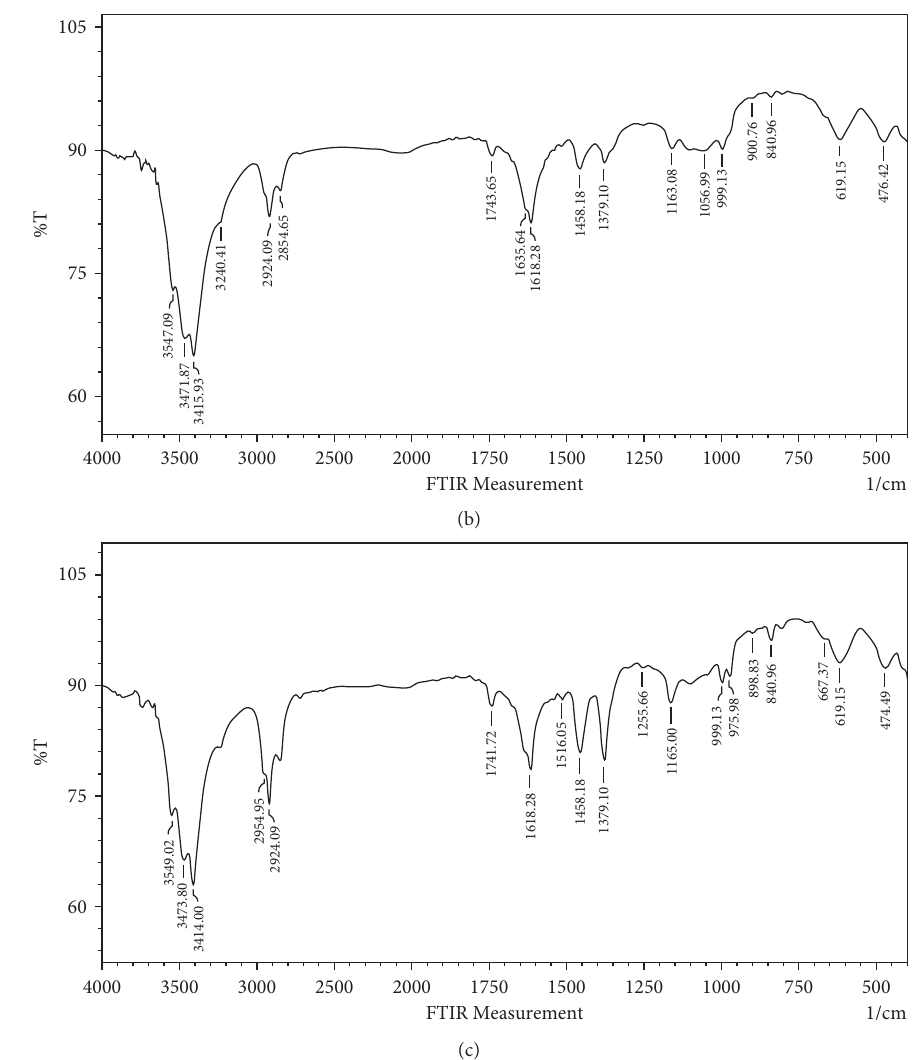
Figure 4: FTIR spectra of (a) okra extract, (b) green synthesized Au NPs (Ok Au NPs), and (c) chemical synthesized Au NPs (Ch Au